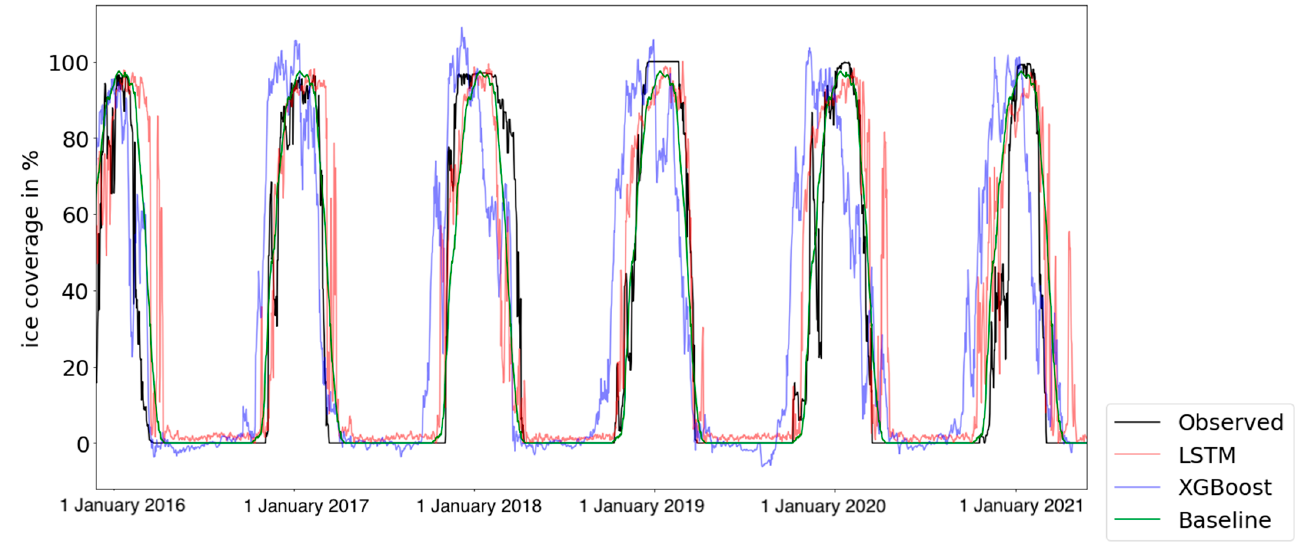
Figure 7. Time series of the ice coverage over the St. Marys River system for 30-day prediction. As for the comparison between LSTM and XGBoost, LSTM performed slightly better than XGBoost did, both for the 7-day and 30-day predictions. In particular for freezing periods and melting periods, the RMSE of XGBoost is notably larger than that of